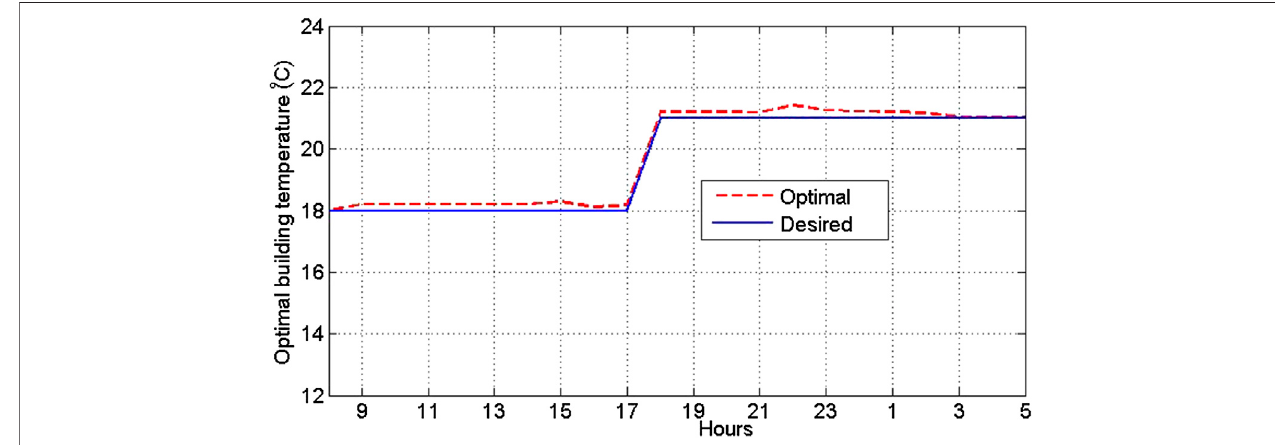
FIGURE 7 | Optimal building ’ s temperature.